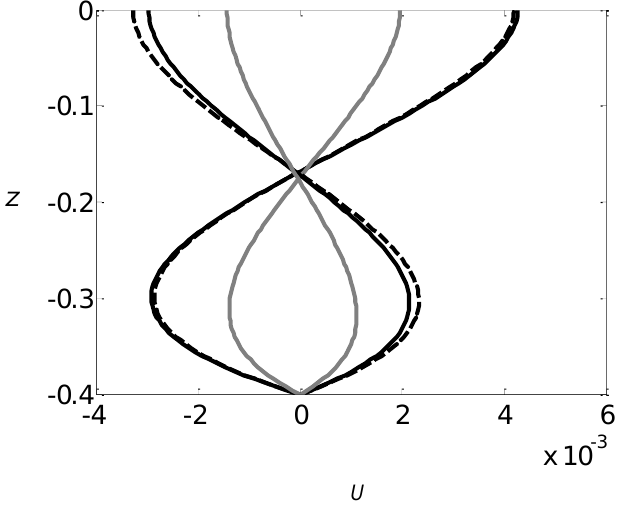
Figure 4. Horizontal velocity profiles in shallows at different times for the full solutions without vegetation (black solid) and with 0.2% vegetation (gray line) and pure viscosity balance (dashed line) solutions for z = 0.4.